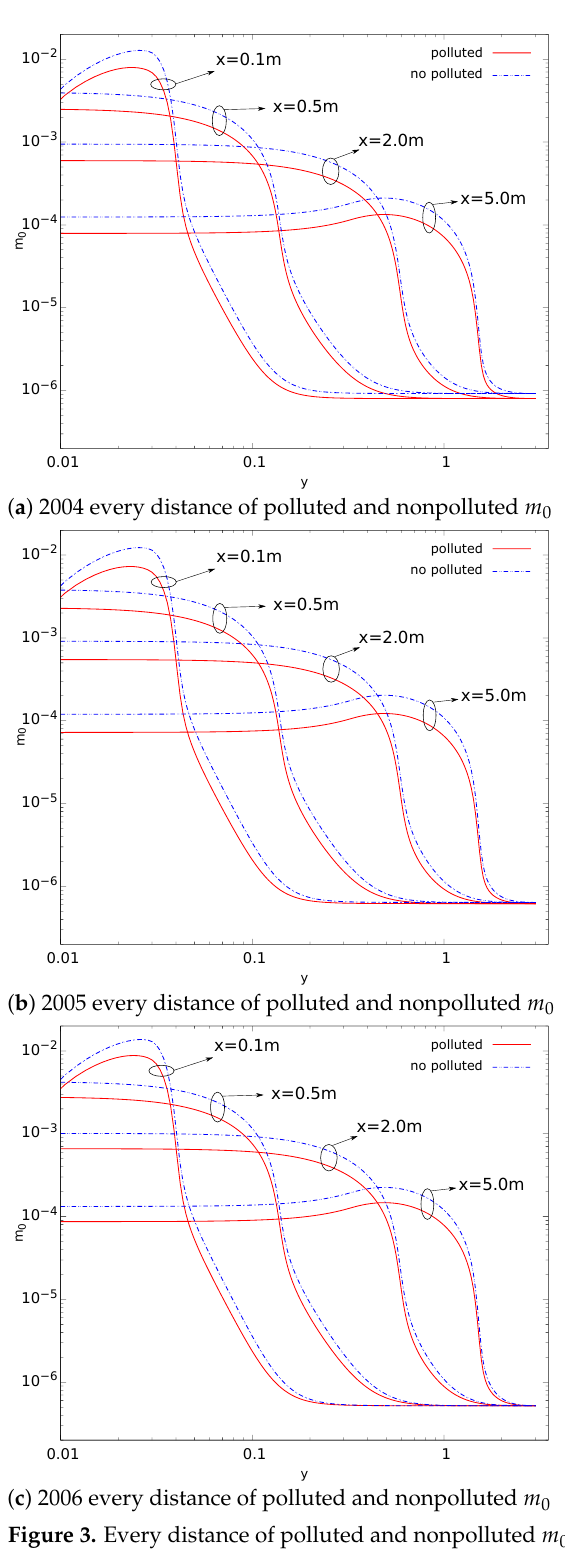
Figure 3. Every distance of polluted and nonpolluted m 0 over three